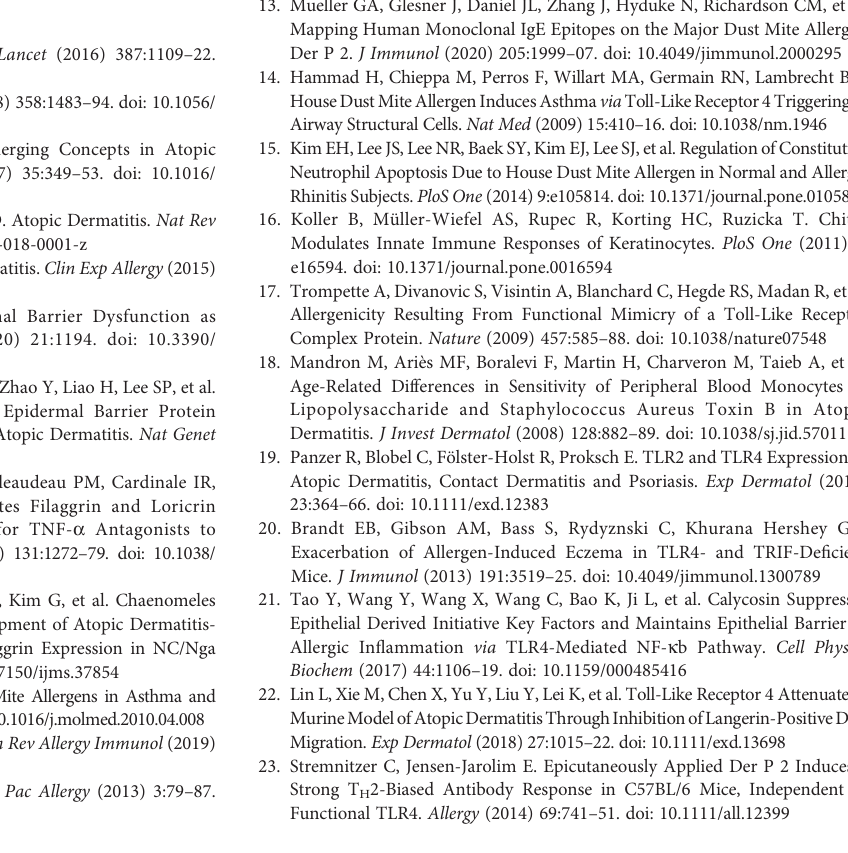
Supplementary Figure 1 | Der p 38 directly binds to TLR4. Recombinant Der p 38 protein was added to a TLR4-bound column, eluted, and separated by SDS- PAGE. The gel was stained with silver stain. Supplementary Figure 2 | Der p 38 has no effect on total and surface TLR4 expression in HaCaT cells. (A, B) HaCaT cells were treated with 10 m g/mL Der p 38 in the indicated time. The harvested cells were lysed, and TLR4 expression was detected by Western blotting (A) and fl ow cytometry (B) . Supplementary Figure 3 | LPS diminishes fi laggrin expression and induces cytokine secretion in human keratinocyte HaCaT cells. (A) HaCaT cells were treated with 1 m g/mL LPS for the indicated time or 10 m g/mL Der p 38 for 48 h. The harvestedcellswerelysed,and fi laggrinexpressionwasanalyzedbyWesternblotting. (B) The cells were treated with 1 m g/mL LPS or 10 m g/mL Der p 38 for 48 h. The supernatant was collected and analyzed by ELISA. The data are presented relative to the control (Con), which was set at 100% as the mean ± S.D. ** p < 0.01 indicates a signi fi cant difference between the untreated and LPS or Der p 38-treated